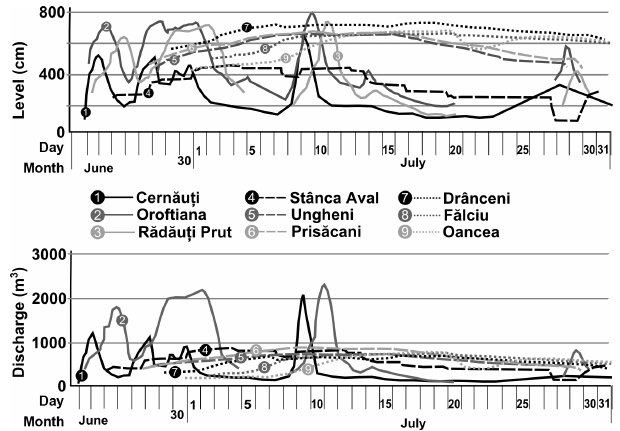
Figure 6. Water levels and discharge on the Prut River at the gauging stations of Cernauti, Oroftiana, R˘ad˘au¸ti-Prut, Stanca Aval (downstream), Ungheni, Prisacani, Drânceni, F˘alciu, and Oancea during the summer of